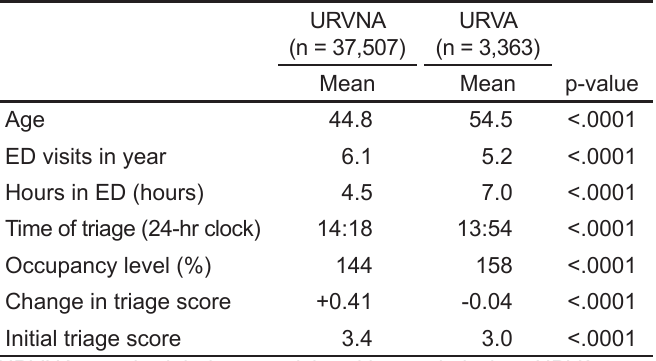
Table 1. Mean comparisons in URVNA and URVA